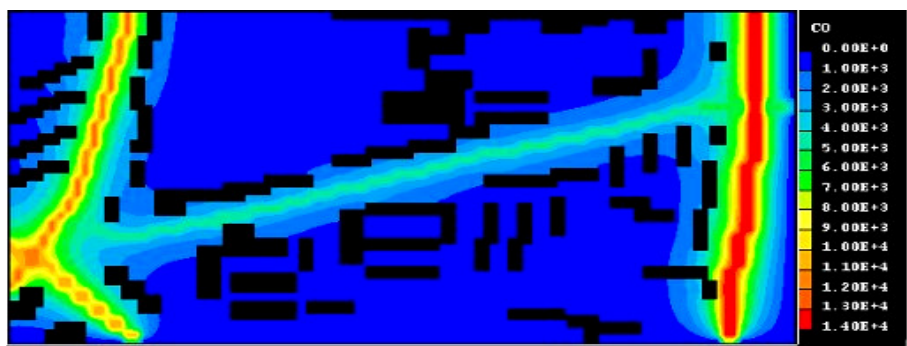
3 in windless weather, CO molecular diffusion in Minties-Žirmūnų streets